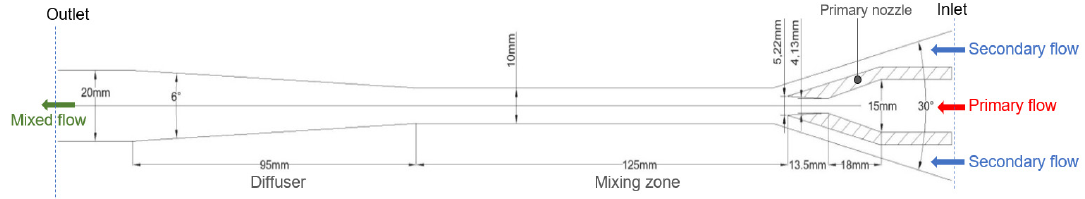
Figure 1. Schematic diagram of the ejector geometries as the base model.